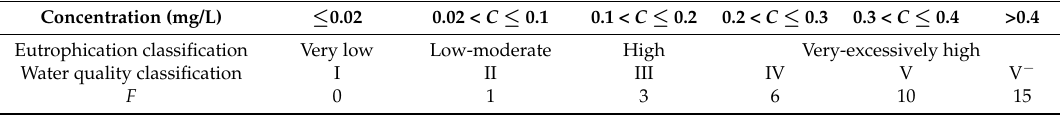
Table 3. Total phosphorus (TP) concentrations and